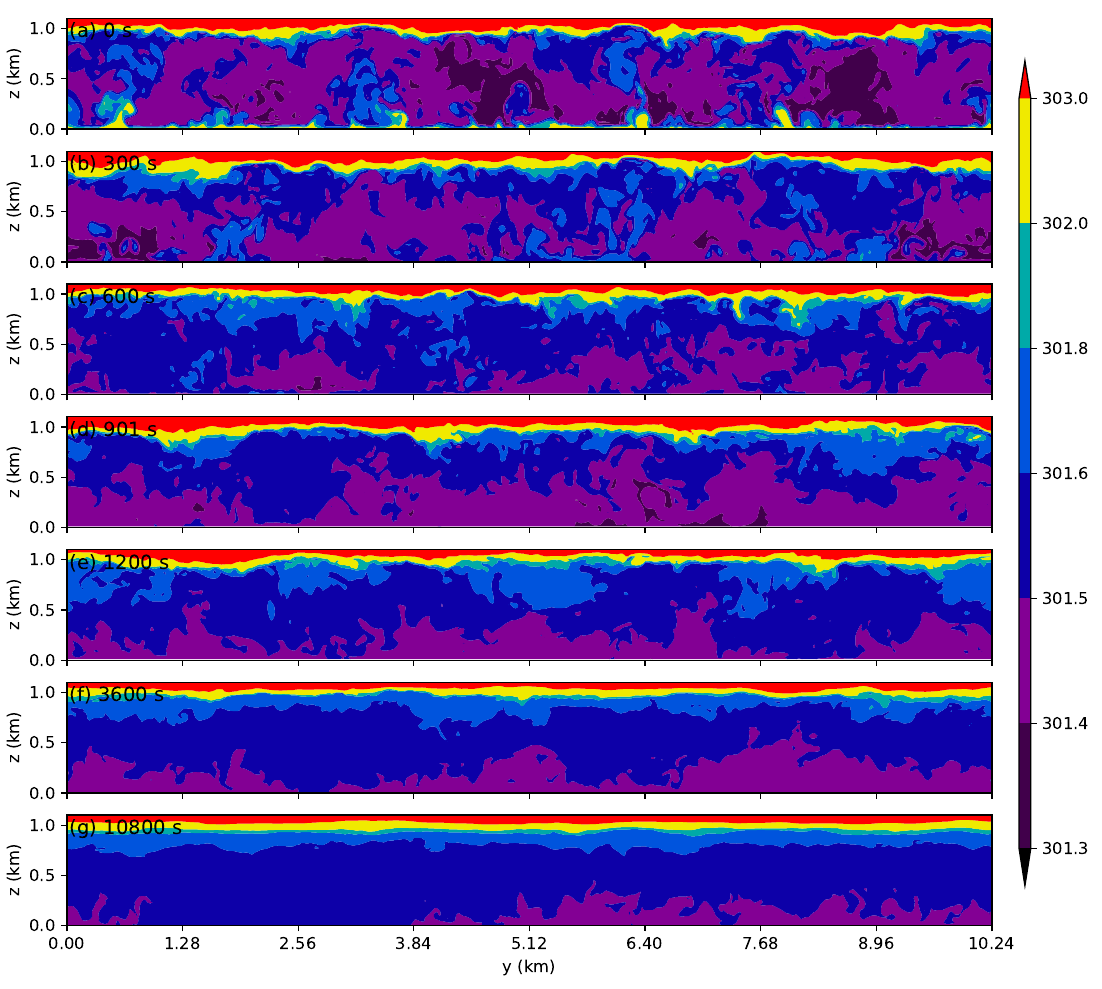
Figure 10. Potential temperature fields at x = 1270 m and t − t c = ( a ) 0, ( b ) 300, ( c ) 600, ( d ) 901, ( e ) 1200, ( f ) 3600, and ( g ) 10,800 s in the advective